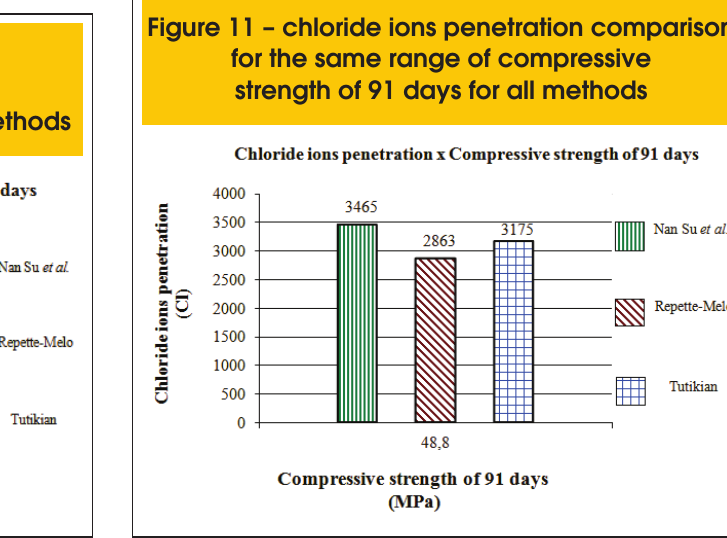
Figure 10 – ultrasound wave speed comparison for the same range of compressive strength of 91 days for all methods